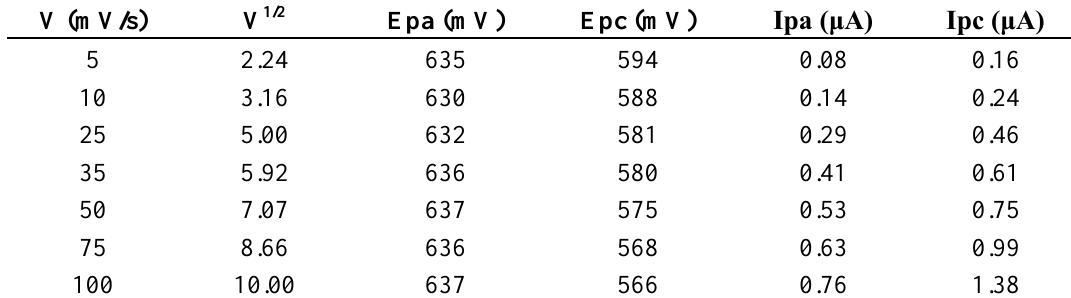
(3-MeO-salen)(H O)]·H 2 2 2